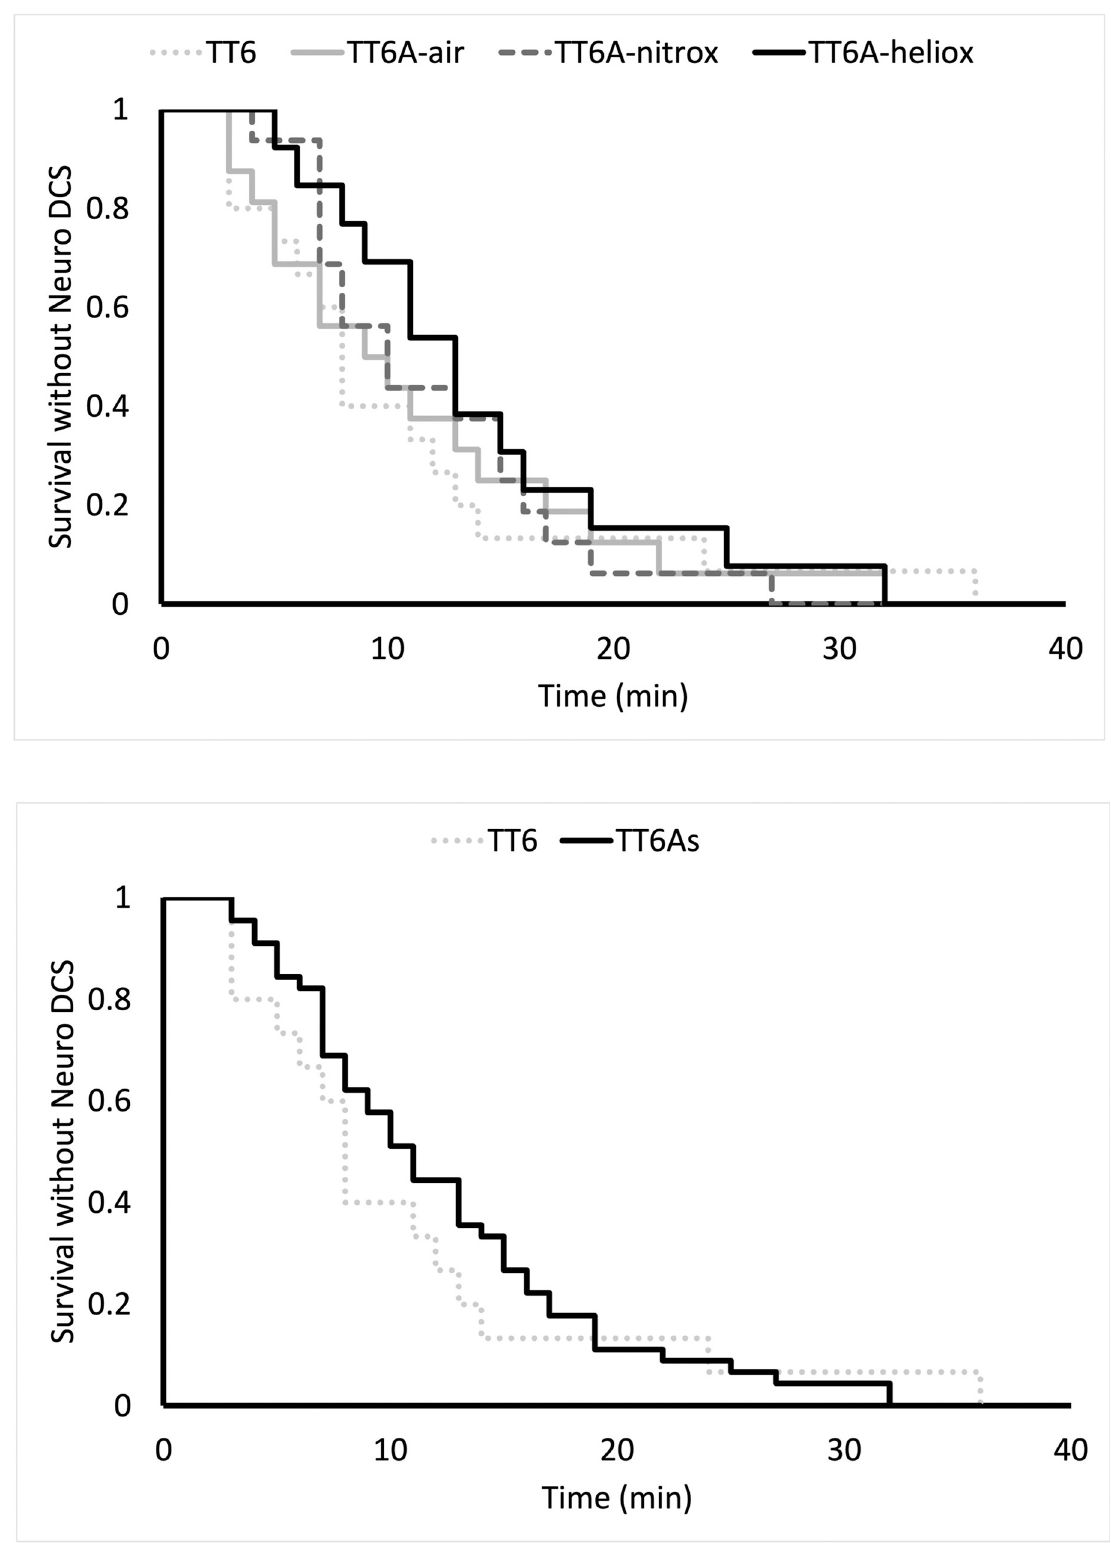
Fig 4. A Kaplan-Meier curve showing the latency to diagnosis of neurologic DCI in each treatment group (A, log rank, p = 0.83) and each treatment profile (B, log rank, p = 0.58). https://doi.org/10.1371/journal.pone.0266236.g004 PLOS ONE | https://doi.org/10.1371/journal.pone.0266236 October 5,